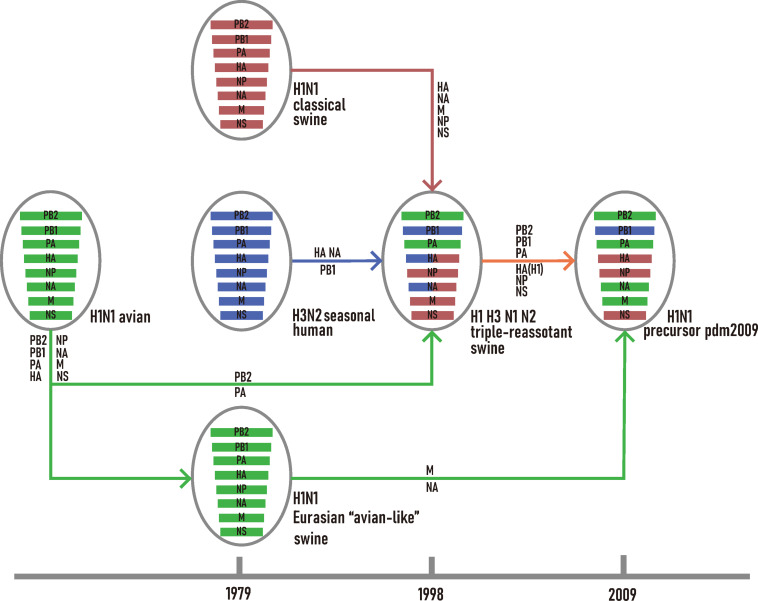
Schematic representation of the genetic reassortant events that led to the development of H1N1/pdm2009. The H1N1 avian lineage, and its descendants are colored in green. The H1N1 classic swine lineage and its descendants are colored in red. The H3N2 seasonal human lineage and its descendants are colored in blue.